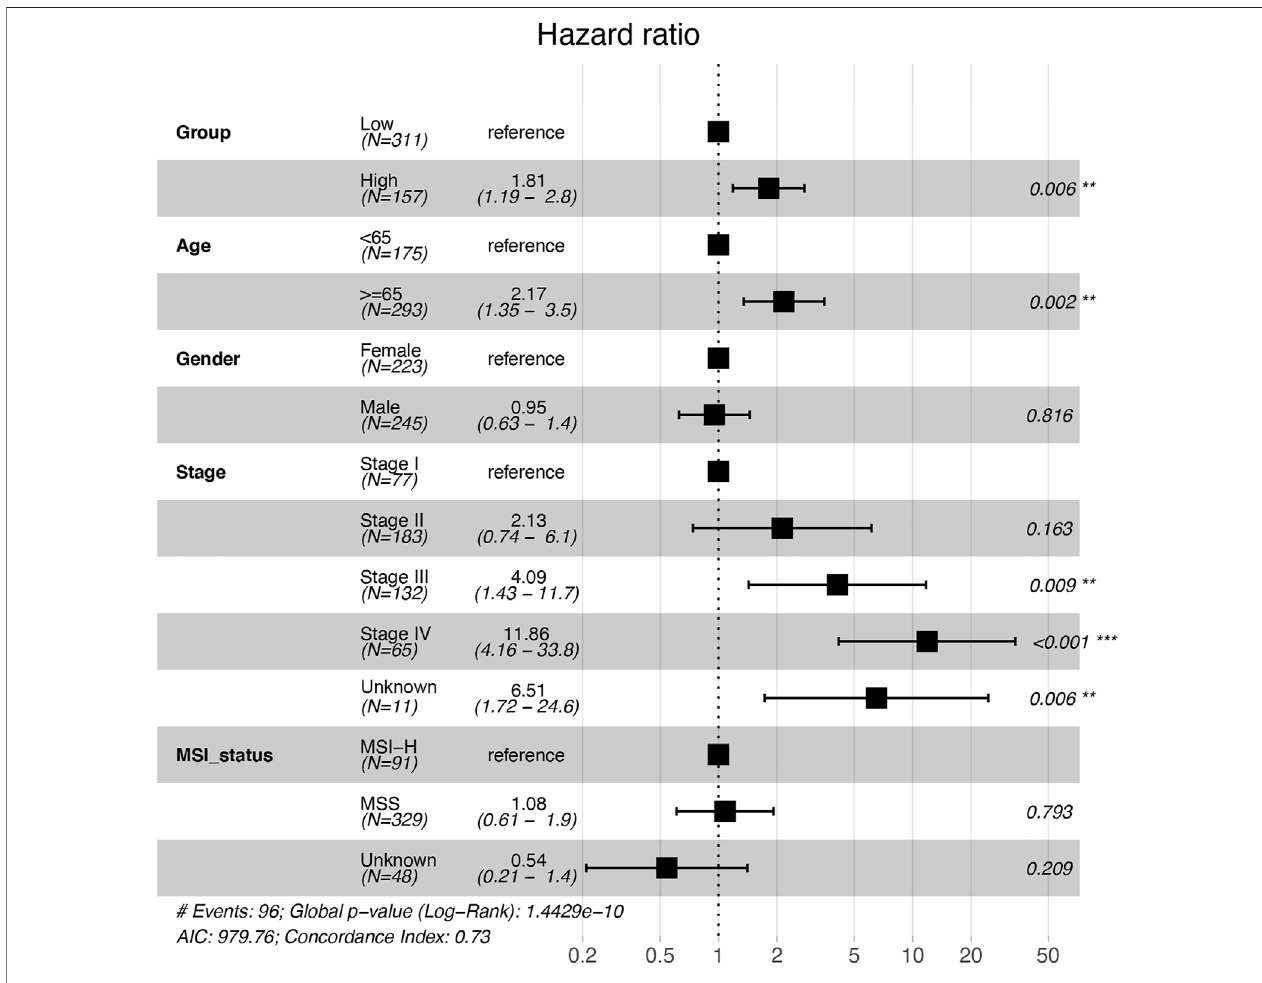
FIGURE2| MultivariateanalysiswiththeCoxproportionalhazardsmodelontheindependentfactorsassociatedwithoverallsurvivalinCOADpatients.*,**,and*** indicate p < 0.05, p < 0.01, and p < 0.001, respectively. COAD: colon adenocarcinoma; MSI-H: microsatellite instability-high; MSS: microsatellite